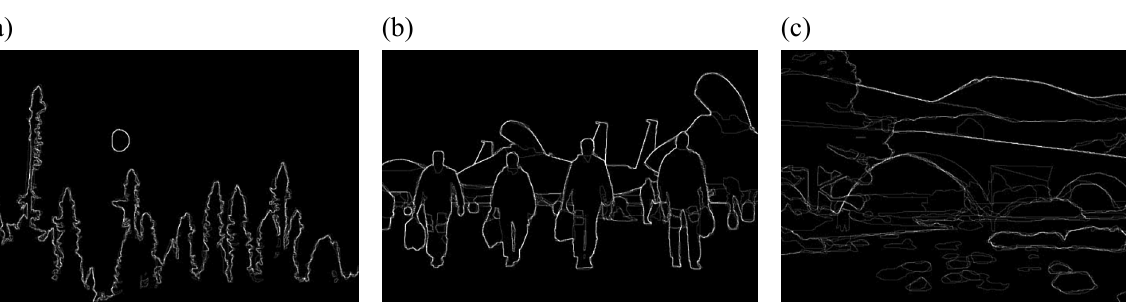
Fig. 4. Ground truth images: (a) with low detail, (b) with medium detail, (c) with high detail.